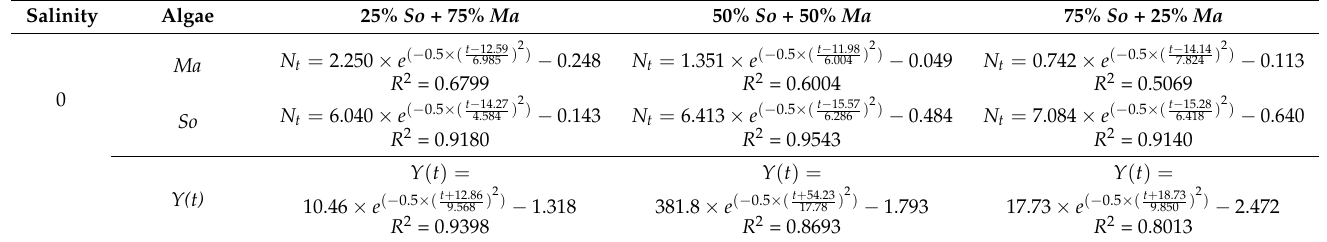
Figure 2. The increase of cell density of M. aeruginosa (blue square) and S. obliquus (green circle) over the 17-day experiment in three different salinities (0, 3, 6). Table 1. Gaussian distribution formulae of the algal cell density versus time of both M. aeruginosa and S. obliquus in cocultures, and the formulae of competitive displacement rate against time of S. obliquus by M. aeruginosa .